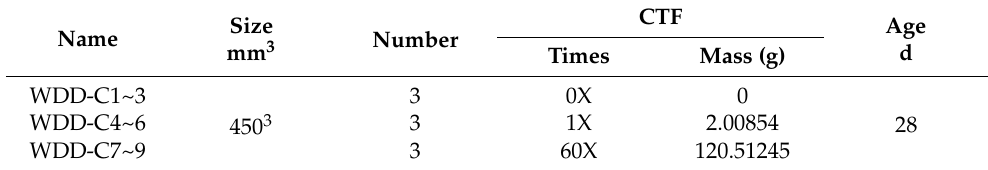
Table 5. Compressive strength test of four-grade concrete with different CTF